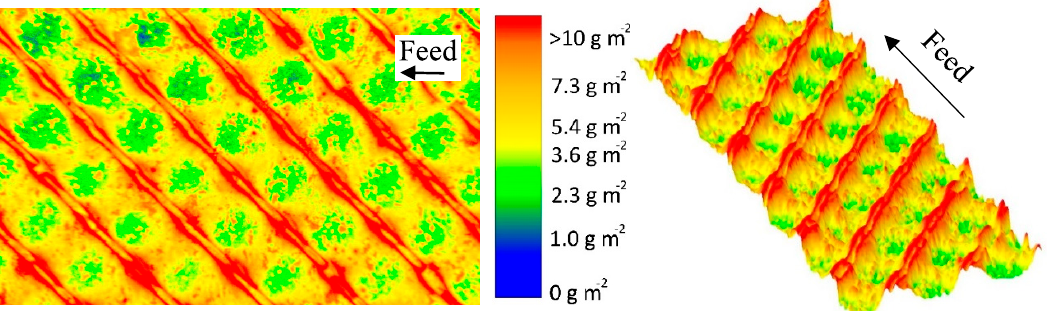
Figure 7. False color and topographic image of the deposit layer formed by a diamond-shaped spacer after filtration of concentrated skim milk (CF 3, Δ p L = 1.0 bar m − 1 , Δ p TM = 0.5 bar). The average amount of deposited protein determined by HPLC was 5.6 g m − 2 . The membrane after staining can be found in the Supplementary Material (Figure S4).